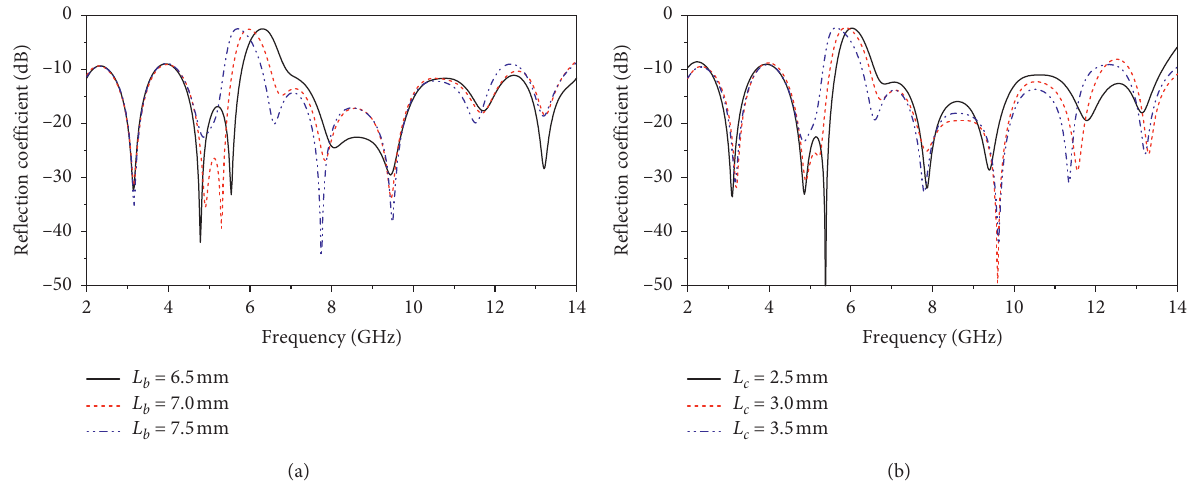
Figure 3: Notch frequency for different geometrical etched slot parameters. (a) The ordinary rectangular slot at the different frequency band from varying the parameter L b . (b) The complementary split-ring resonance at the different frequency band from varying the parameter L c .